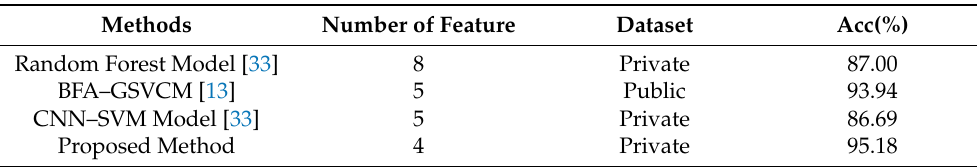
Table 4. The classification performance of the proposed